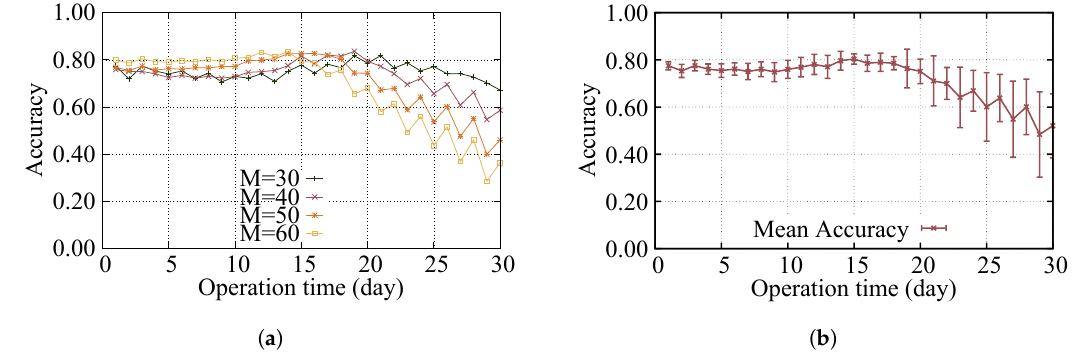
Figure 5. Prediction accuracy of RUL with different days ahead ( a ); Mean prediction accuracy of RUL ( b ).